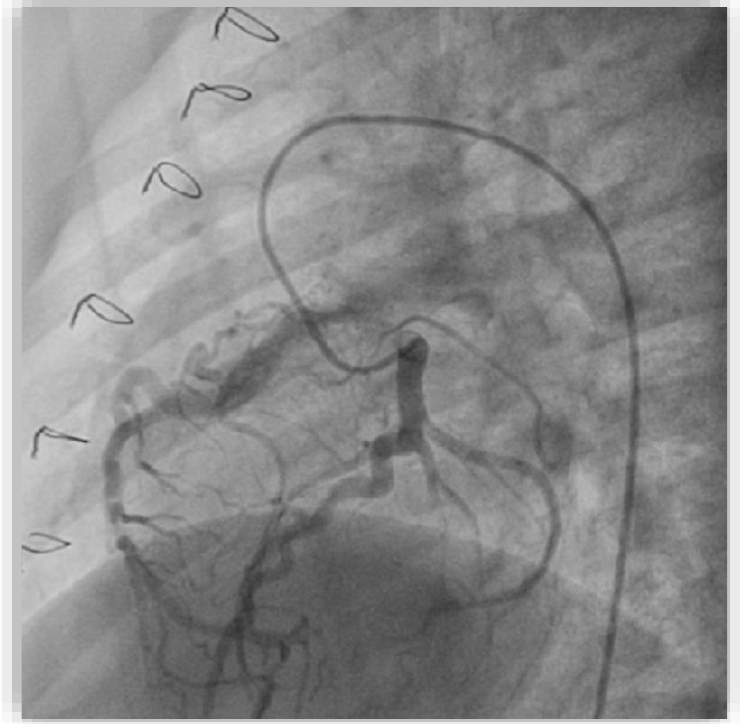
Figure 9. Selective coronary angiography into the left coronary artery in the anteroposterior view with left and caudal angulation showing dilated left coronary arteries and branches with collateral circulation towards the right coronary artery connected to the pulmonary artery.